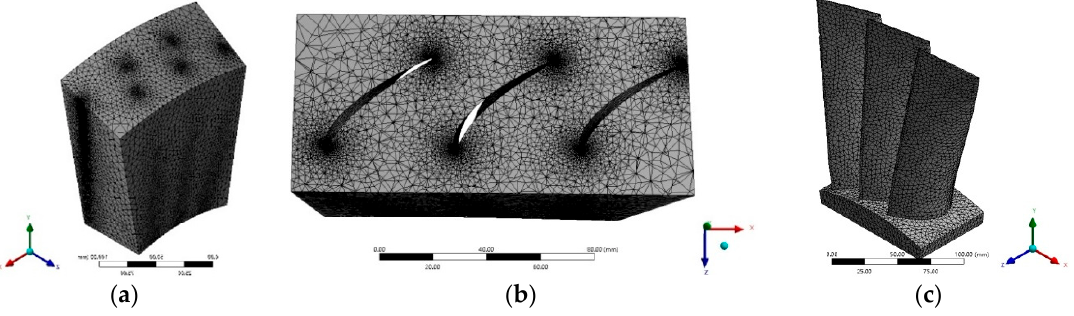
Figure 4. [51] . Meshes of the blade and flow field model. ( a ) Mesh of the whole flow field model; ( b ) cutaway view of the mesh of the blade model; ( c ) mesh of the blade model. ANSYS CFX is applied to conduct the numerical simulation analysis. The three-dimensional nonlinear Navier–Stokes computational fluid dynamics (CFD) solver and the structural mechanics finite element solver are used to execute the analysis. The CFD solver is used to simulate the flow field around the blade under the pre-set boundary conditions to obtain the aerodynamic load acting on the blade deformation of the blade shape is calculated by the structural mechanics solver.